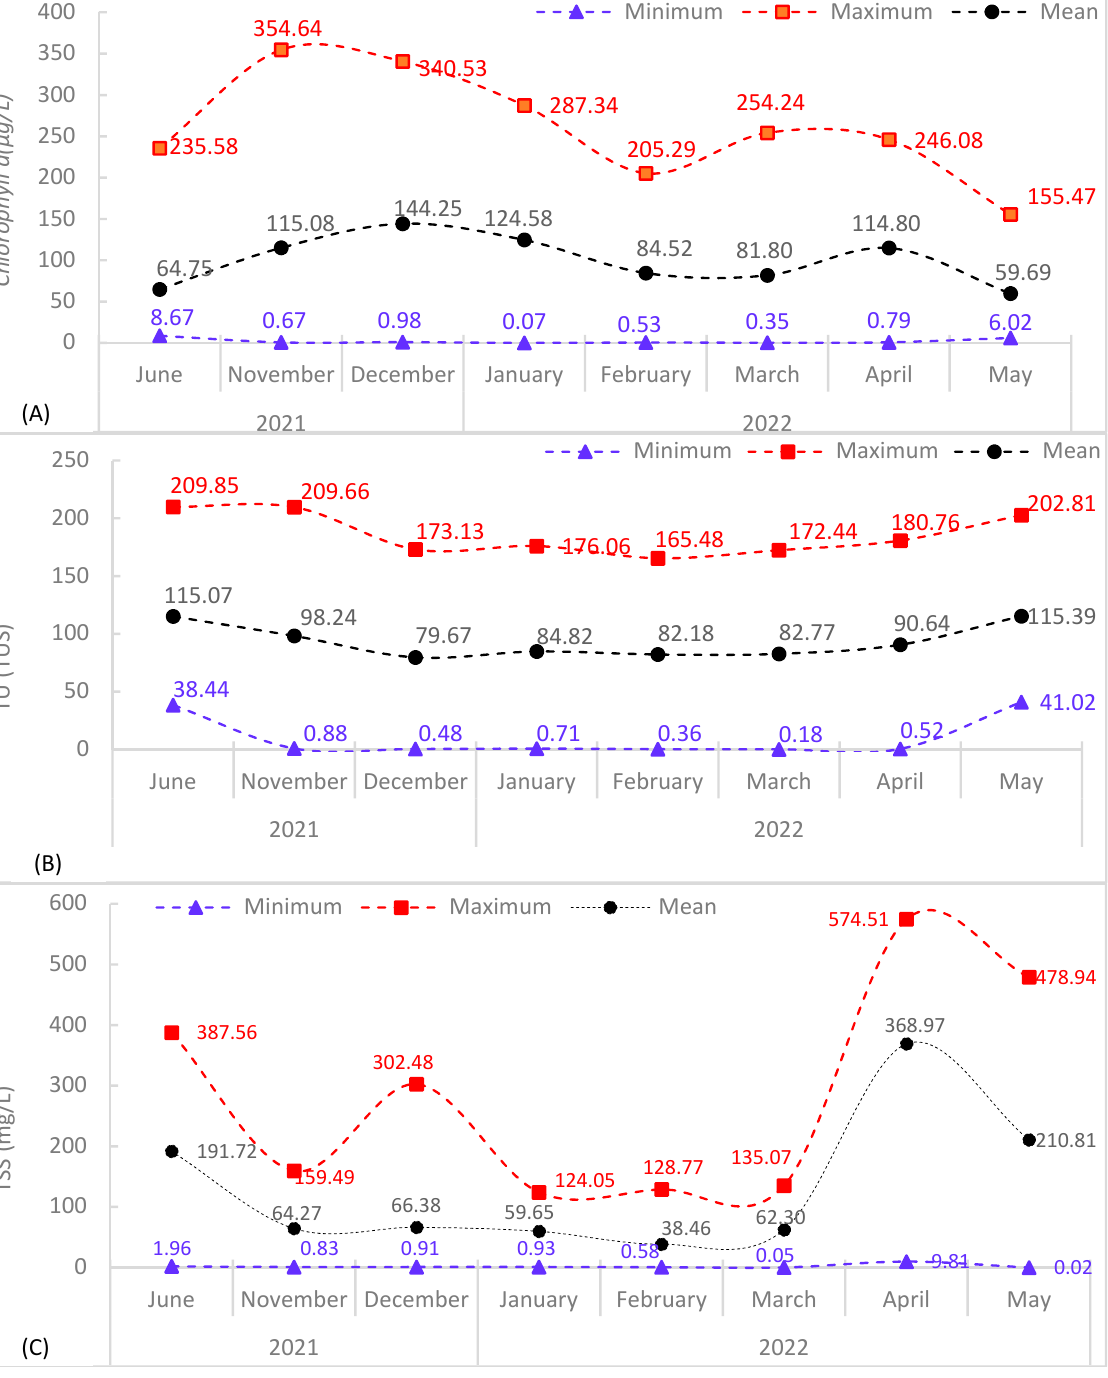
Figure A4. Monthly basis temporal WQPs from Sentinel 2A satellite image using linear regression models Equations (8)–(10). ( A ) Chlorophyll a (µg/L), ( B ) Turbidity (NTU), ( C ) Total Suspended Sediment (mg/L).